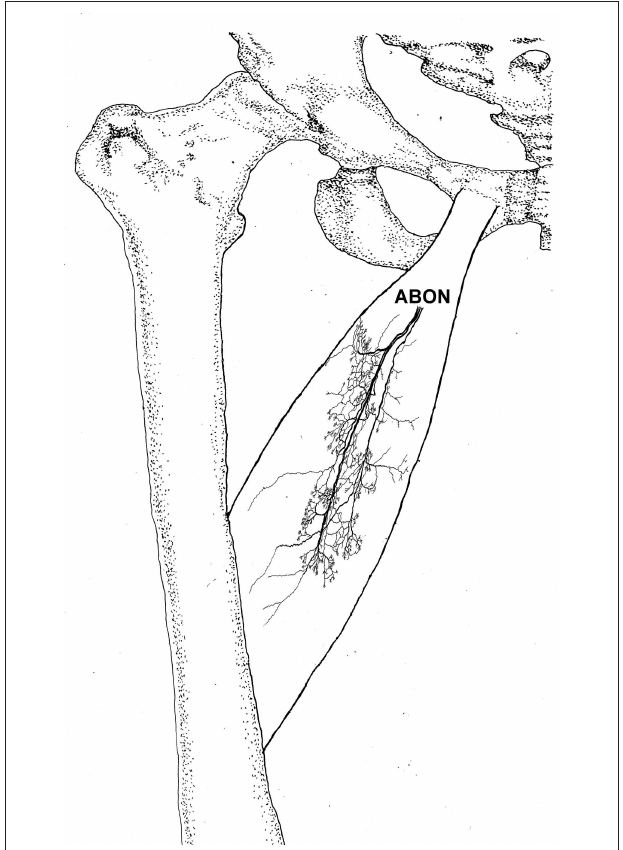
FIGURE 2 | Three dimensional pattern of intramuscular nerve distribution in the adductor longus (right, deep side; ABON, anterior branch of the obturator